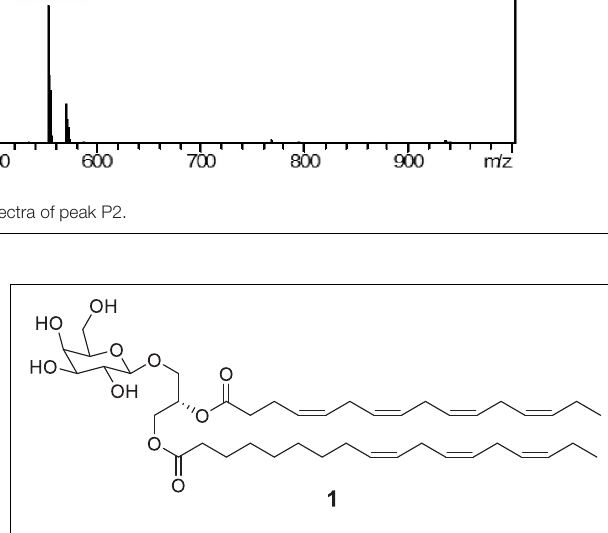
FIGURE 5 | Chemical structure of glycerol 1-(9Z,12Z,15Z-octadecatrienoate) 2-(4Z,7Z,10Z,13Z-hexadecatetraenoate)-3-O- β -D-galactopyranoside